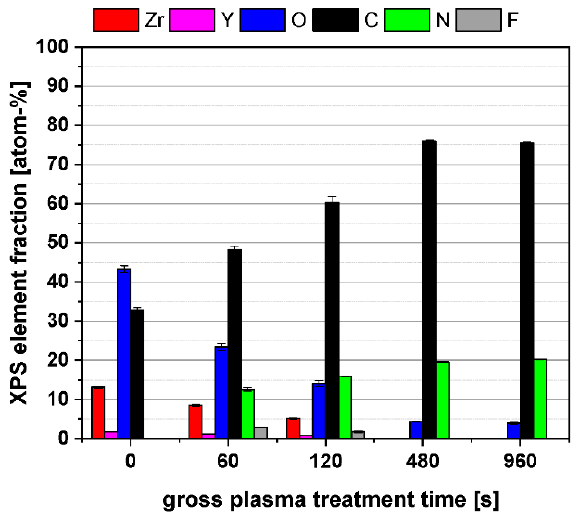
Figure 9. XPS elemental content after PPAAm coating of smooth ceramic dependent on the treatment time. The trace elements Al, Si, and Na were omitted.